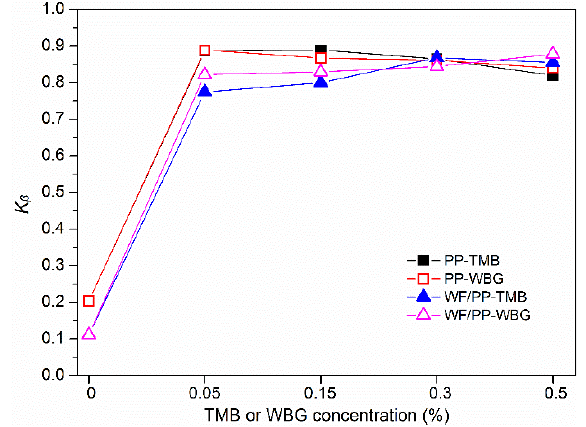
Figure 3. Variation of relative content of β -form crystal ( K β ) with TMB5 or WBG II concentration for PP-TMB, PP-WBG, WF/PP-TMB, and WF/PP-WBG.